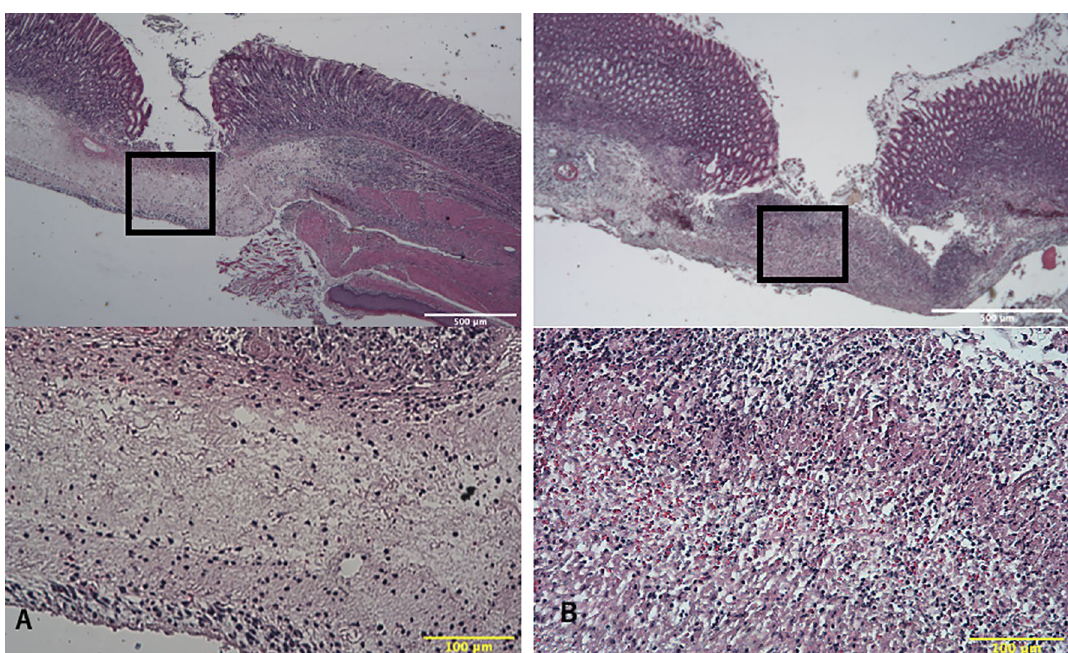
Figure 2. Histopathology findings. ( A ) Microscopic view of the ulcer 48 h after hydrogel application in the hydrogel group. ( B ) Microscopic view of the ulcer 48 h after saline application in the control group. Black squares indicate the mucosal defect area. The density of the number of inflammatory cells in the mucosal defect area was assessed. Yellow bars indicate 100